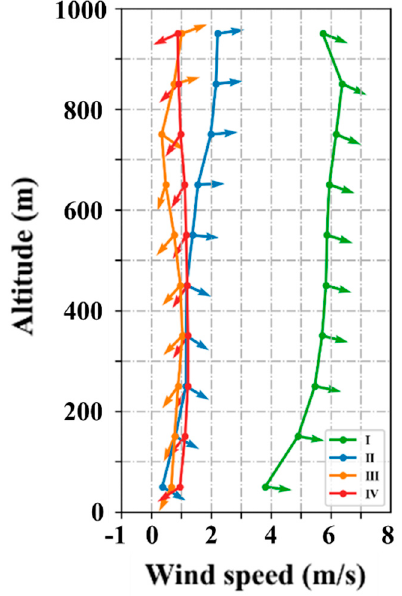
Figure 7. Mean wind profiles under different degrees of pollution (PM 2.5 concentrations: period I (<35 ug/m 3 ), period II (35–75 ug/m 3 ), period III (75–115 ug/m 3 ) and period IV (>115 ug/m 3 ); arrows represent the average direction with respect to the north).